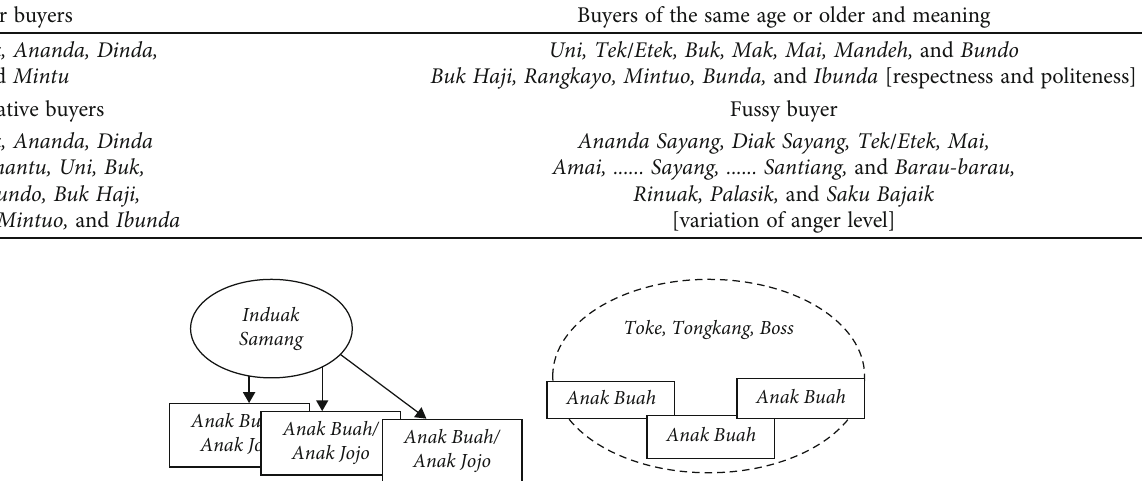
Figure 3: Induak Samang usually has its store separated from Anak Jojo ’ s small store. Tongkang, Toke , or Boss usually have a store where Anak Buah in